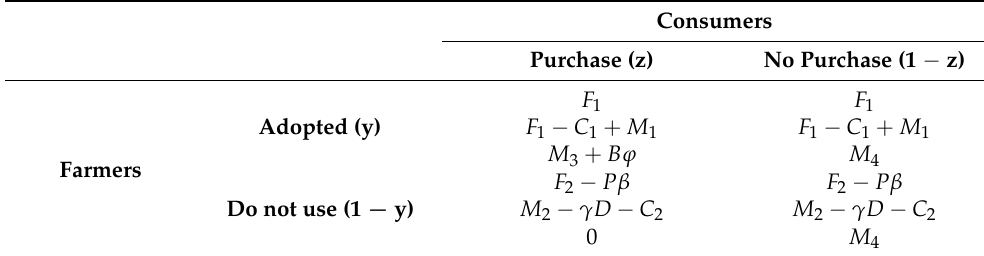
Table 3. The income matrix of the farmer-consumer evolutionary game in the context of government